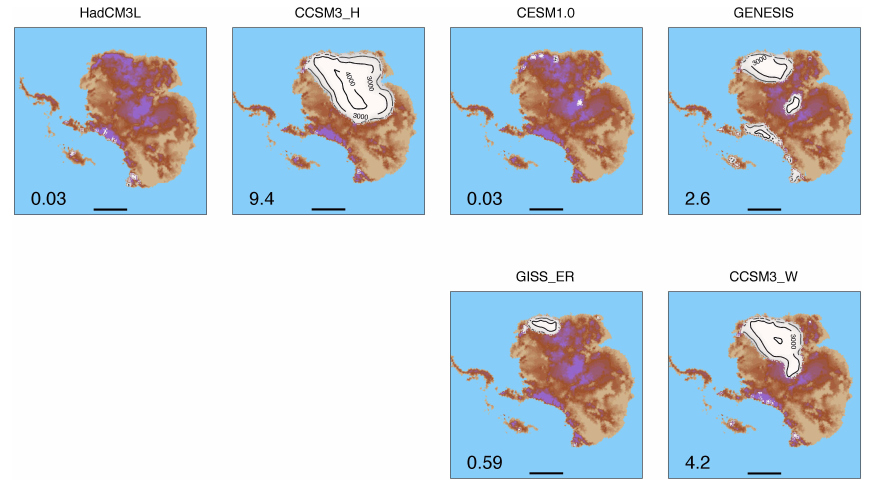
Fig. 3. Offline 4 × PIC simulations of the Antarctic ice sheets forced by the HadCM3L early Eocene simulation of Lunt et al. (2010), CCSM3_H simulation of Huber and Caballero (2011), CESM1.0 simulation of Goldner et al. (2013), GENESIS simulation of DeConto et al. (2008), GISS_ER simulation of Roberts et al. (2009) and CCSM3_W simulation of Winguth et al. (2010). The 4 × PIC GISS_ER simulation includes an additional CH 4 forcing, which Roberts et al. (2009) estimate makes this simulation equivalent to a 4.3 × PIC simulation. Bedrock scale same as in Fig. 1, total ice volumes shown on Figures are in 10 6 km 3